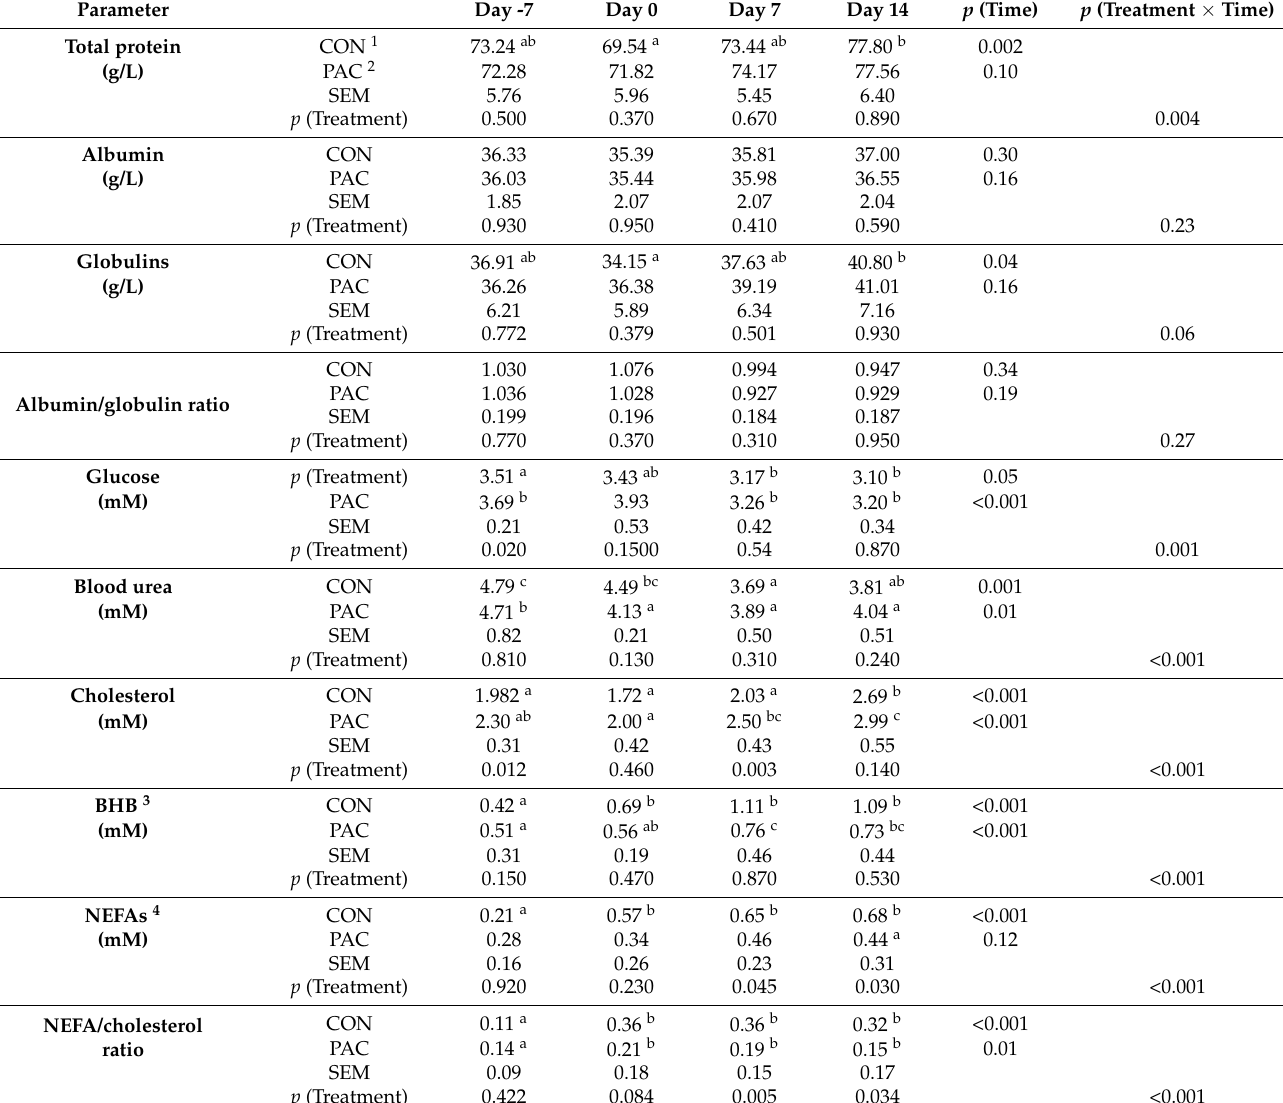
Table 3. Serum metabolite concentrations in cows receiving plant bioactive